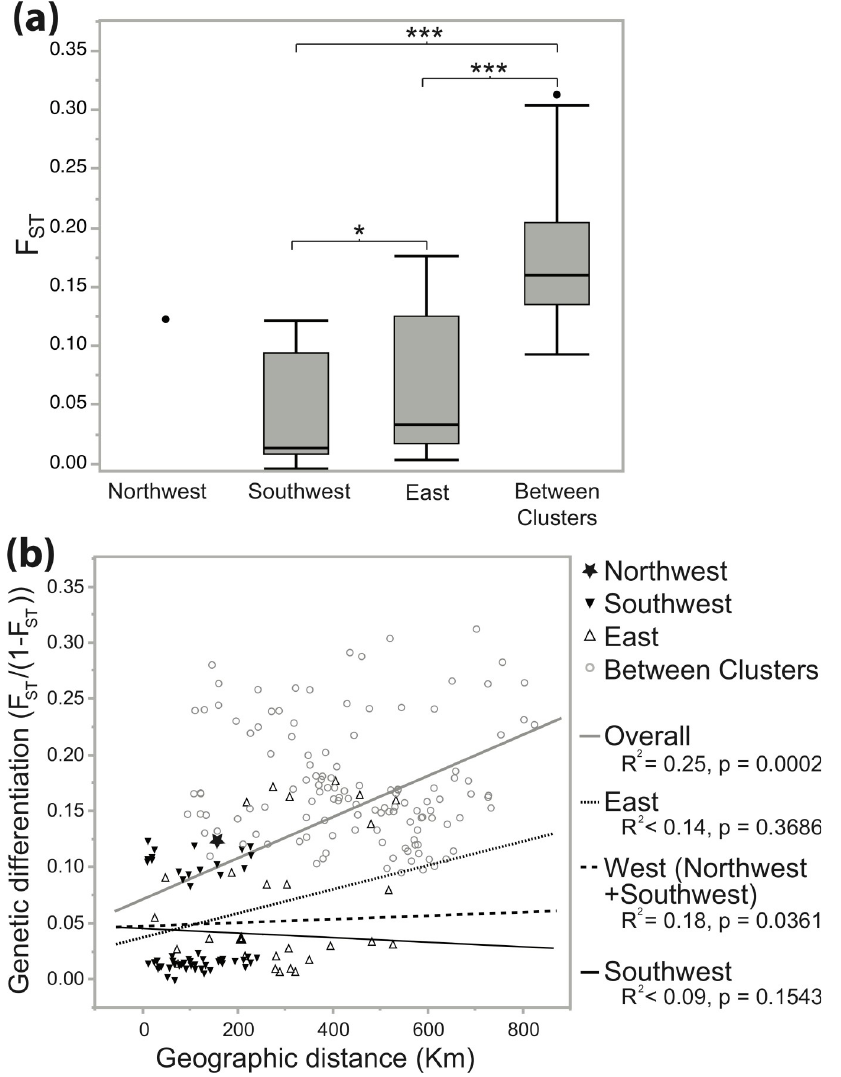
Fig 3. Comparison of F ST among and between clusters, and relationship between F ST and geographic distance. (a) Genetic differentiation (F ST ) computed in Arlequin [44] based on Weir and Cockerham 1984 [65] within and among clusters. Box plots show the mean, 1 st and 3 rd quartile, 95% quantiles (whiskers) and outliers (dots). Student’s t-tests indicated that average F ST was significantly lower in the Southwest than the East (p = 0.0273, marked � ), and significantly higher between-cluster comparisons than in the southwest or east (p < 0.0001, marked ��� ). (b) Genetic versus geographic distance using F ST /(1- F ST ) to correct for finite population sizes [66] plotted for the northwest (star), southwest (downward pointing triangles), east (upward pointing triangles), and between clusters (grey circles), with linear line of best fit with R 2 and p-values for Mantel tests for isolation by distance [66,68]performed in the “isolation by distance” web service v3.23